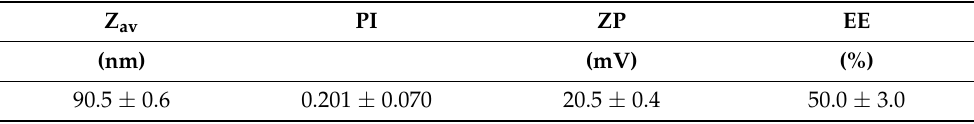
Table 2. Physicochemical parameters of bLF-LIP after adding HA.